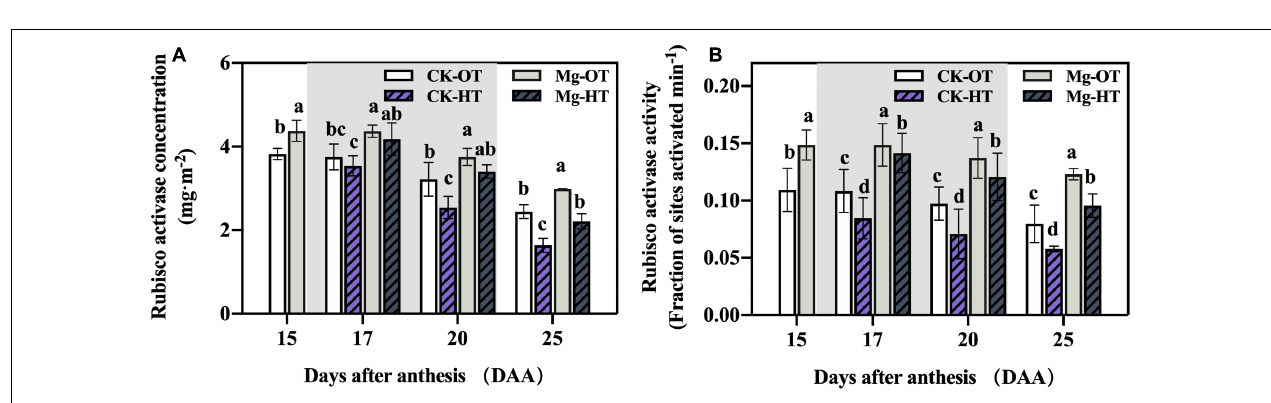
FIGURE 4 | Effect of Mg application on Rubisco activase concentration and activity under HTS during the grain filling stage. Two-way analysis of variance was performed; each bar is the mean ± SE of five replications. Different lowercase letters indicate significant variations within the same day at P < 0.5 (Duncan’s multiple-comparison tests). (A) Rubisco activase concentration, (B) Rubisco activase